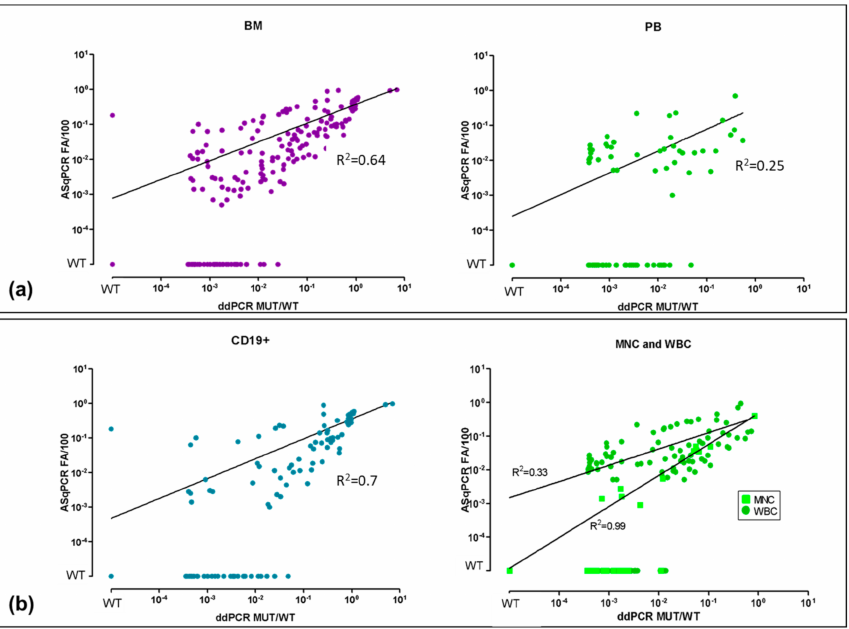
Figure 2. ASqPCR vs. ddPCR in different specimens. Comparison between ASqPCR and ddPCR for MYD88 L265P detection in terms of ratio between MUT and WT in ( a ) BM vs. PB and ( b ) CD19+ vs. MNC and WBC. BM: bone marrow; PB: peripheral blood; WT: Wildtype (quantitative value outside the limit of blank. Limit of blank was calculated based on healthy subjects as the mean value +1 SD); MNC: mononuclear cells; WBC: white blood cells; 10 − 4 : 1 × 10 − 4